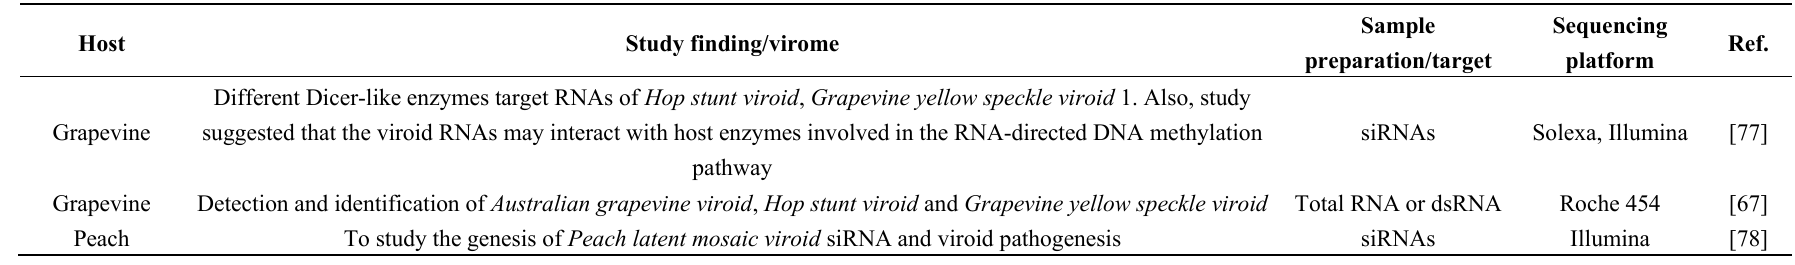
Table 6. Next-generation sequencing of isolated siRNA or dsRNA from viroid-infected grapevine, peach, cucumber, Nicotiana benthamiana or tomato hosts.